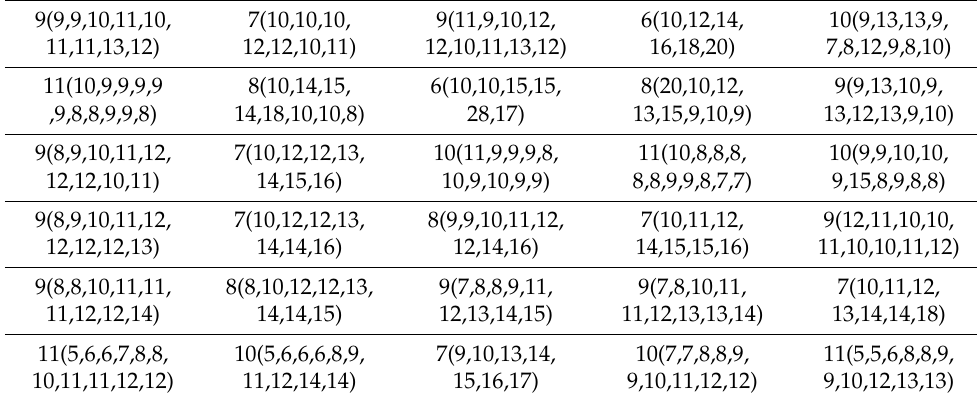
Table 3. Disassembly times t 1 of the joint qualified for Rec collected during available periods (a shift), j q = 1,2, . . . ,30. The Number of Cycle Times (and Disassembly Times of the Joint for Rec) in Available Periods